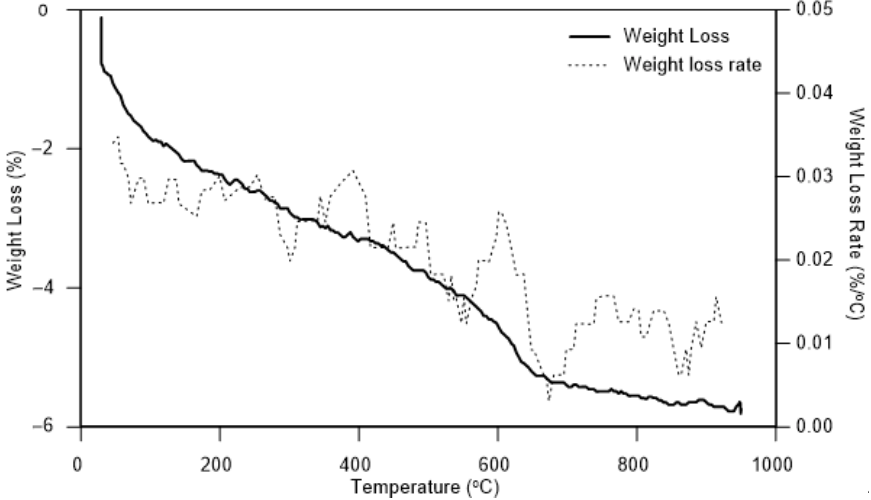
Figure 3. X-ray diffraction patterns for the investigated expansive clay: ( a ) coarse sample; ( b ) clay sample.